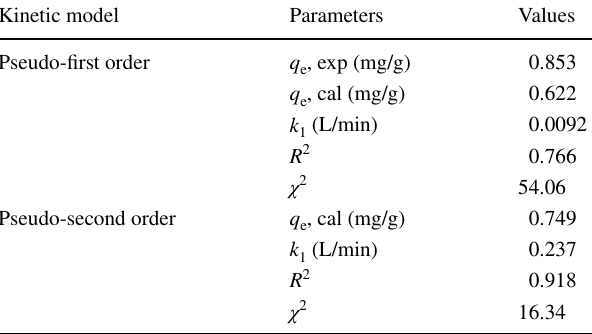
Table 2 Kinetics parameters for the adsorption of CR onto banana peel